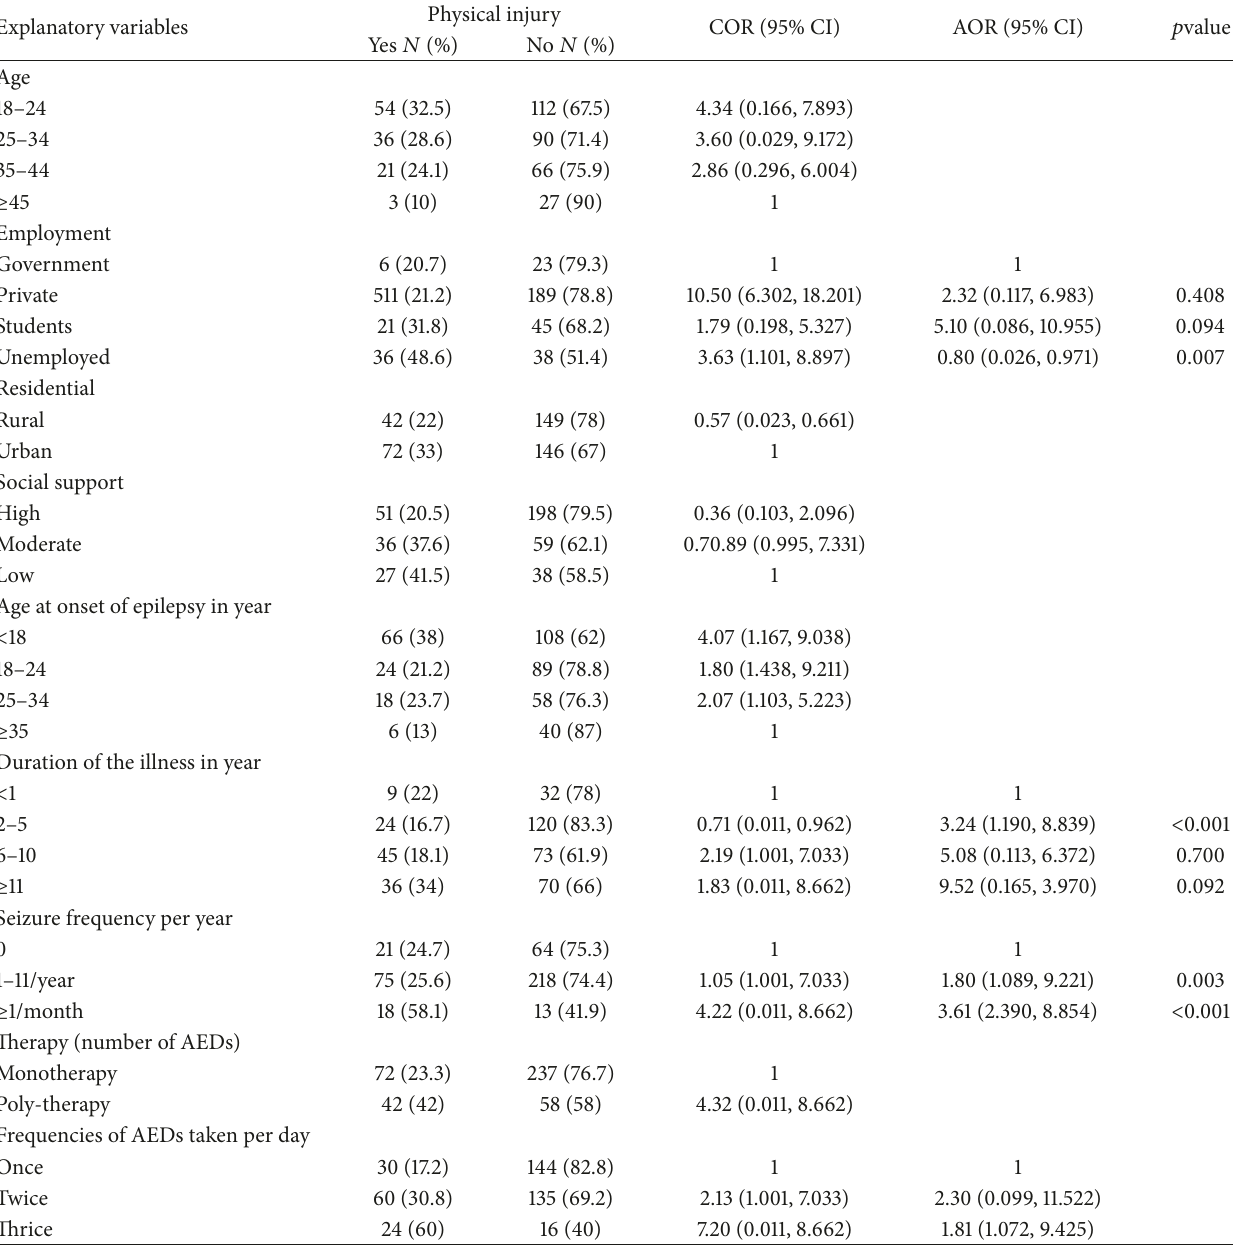
Table 1: Factors associated with physical injury (bivariate and multivariable) analysis ( 𝑛 = 409